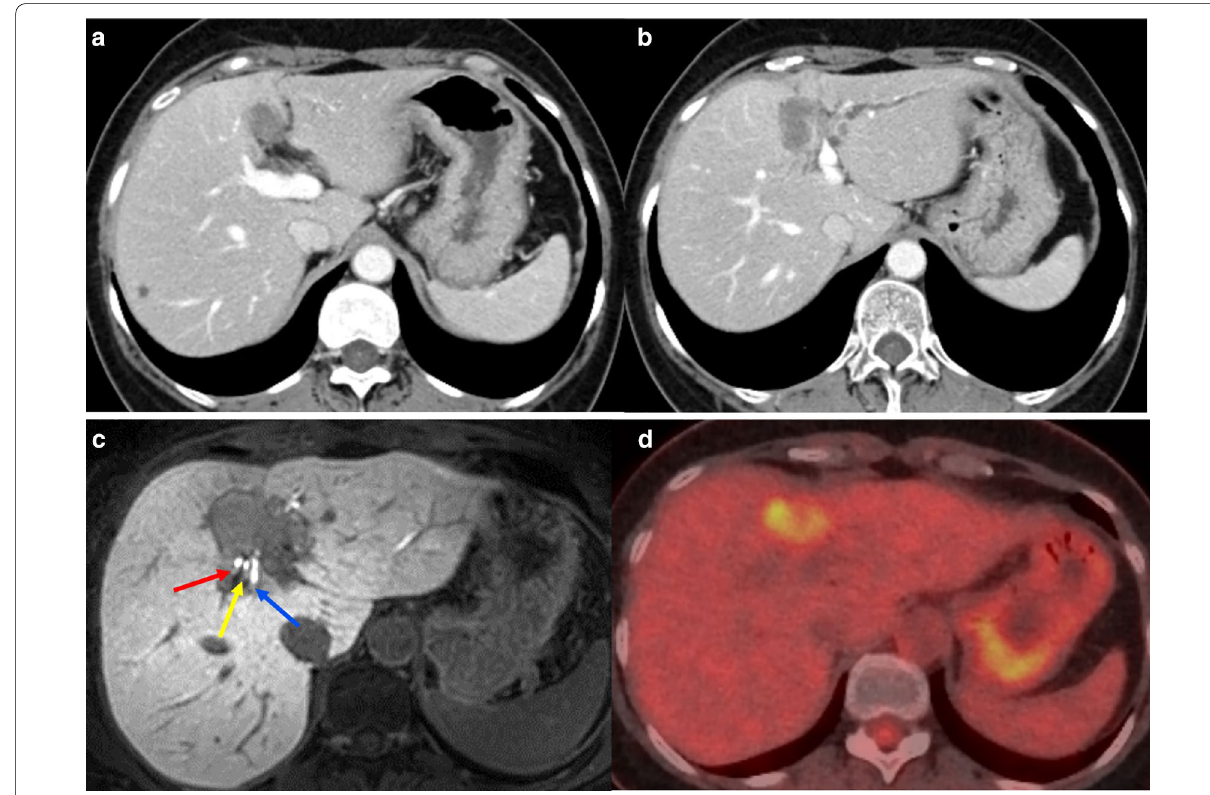
Fig. 2 Images after total 10 courses of the combination chemotherapy with gemcitabine plus cisplatin. a , b Contrast-enhanced abdominal CT showed the tumor had decreased to 38 35 mm (42% reduction). c The tumor was close to the hilar plate. But no findings of invasion to right × anterior dorsal bile duct (red arrow), right anterior ventral bile duct (yellow arrow) and right posterior hepatic duct (blue arrow) were observed magnetic resonance imaging. d FDG-PET/CT showed FDG uptake of tumor had decreased SUV max